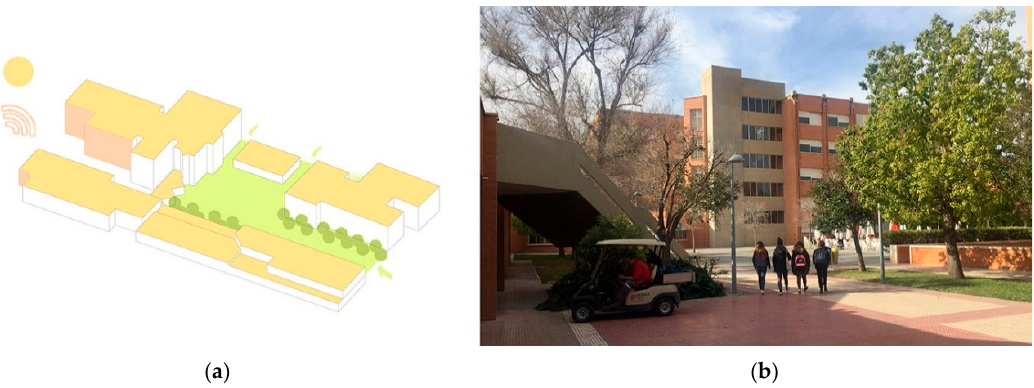
Figure 5. Sketch of adjacent area ( a ) and plaza ( b ) next to the FS. Drawing: Carlos Pastor García. Photo: Authors.